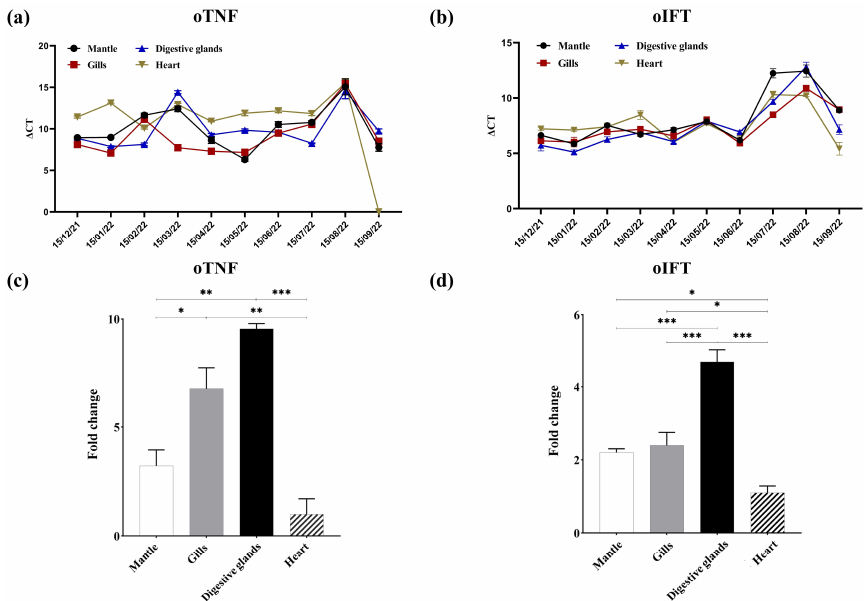
Figure 6. The mRNA levels of oTNF ( a ) and oIFT ( b ) in four oyster tissues from December 2021 to September 2022. The average fold change (mRNA level in tissue/mRNA level in the heart) of mRNA levels of oTNF ( c ) and oIFT ( d ) in four different tissues. (*, p < 0.033; **, p < 0.002; ***, p < 0.001).